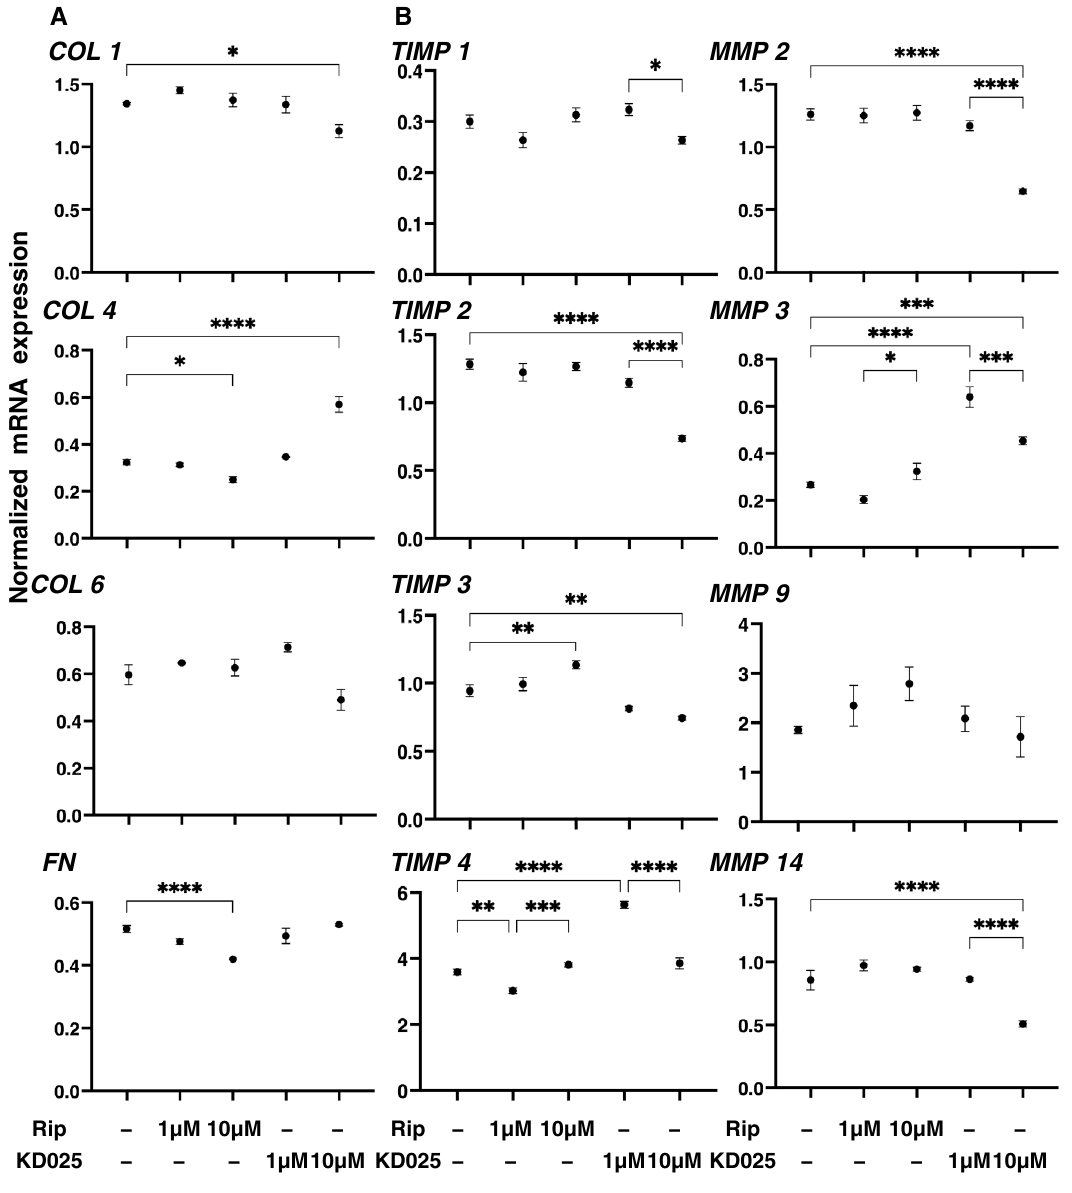
Figure 1. mRNA expression of ECM proteins, and their modulators, TIMPs (1–4) and MMPs (2, 3, 9, 14) in 2D cultured human corneal stroma fibroblasts (HCSFs). In the absence or presence of 1 μM or 10 μM ROCK-is, ripasudil (Rip), or KD025, 2D cultures of HCSFs at Day 6 were subjected to qPCR analyses to estimate the mRNA expression of ECM proteins including those for COL1 , COL4 , COL6, and FN, and their modulators, TIMPs (1–4) and MMPs (2, 3, 9, 14). All experiments were performed in duplicate using fresh preparations (n = 5, each). Data are presented as the arithmetic mean ± standard error of the mean (SEM). * P < 0.05, ** P < 0.01, *** P < 0.005, **** P < 0.001 (ANOVA followed by a Tukey’s multiple comparison